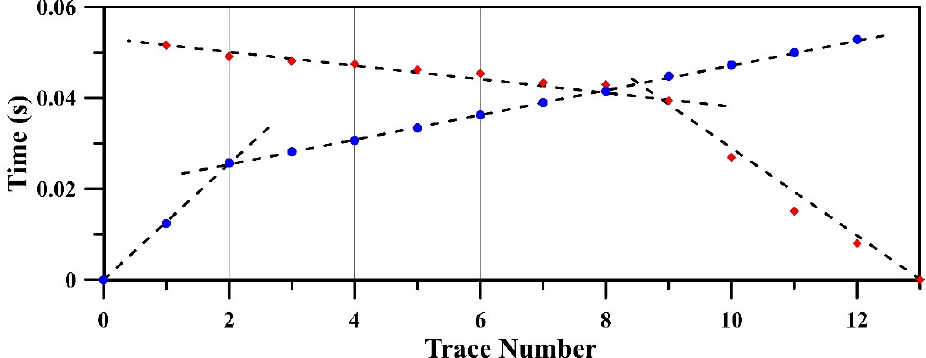
Figure 5. Raw first arrival travel times of shot gathers 1 (circles) and 3 (crosses) picked manually for the 12 traces used in this study. Table 3. Measured position coordinates using D-GPS and position errors of the 12 studied traces. Position errors are measured with respect to the ideal spacing of 4 m giving a relative mean and standard deviation of about 0.35% and 1%,